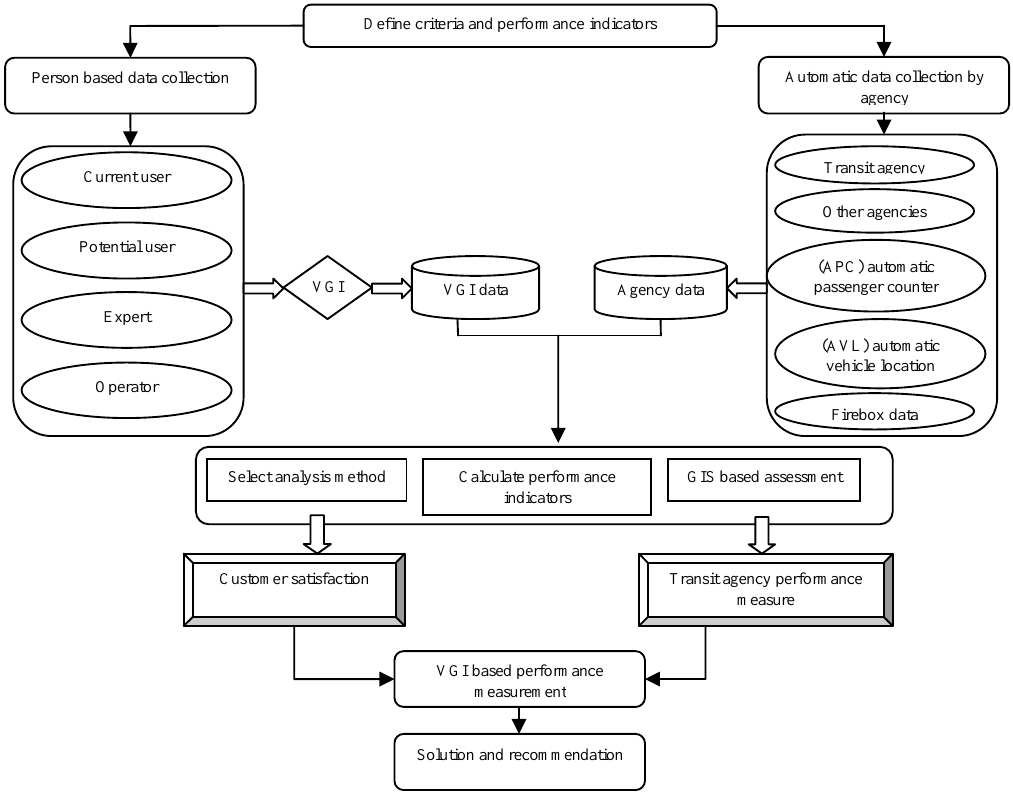
Figure 4: Conceptual framework for VGI based public transport